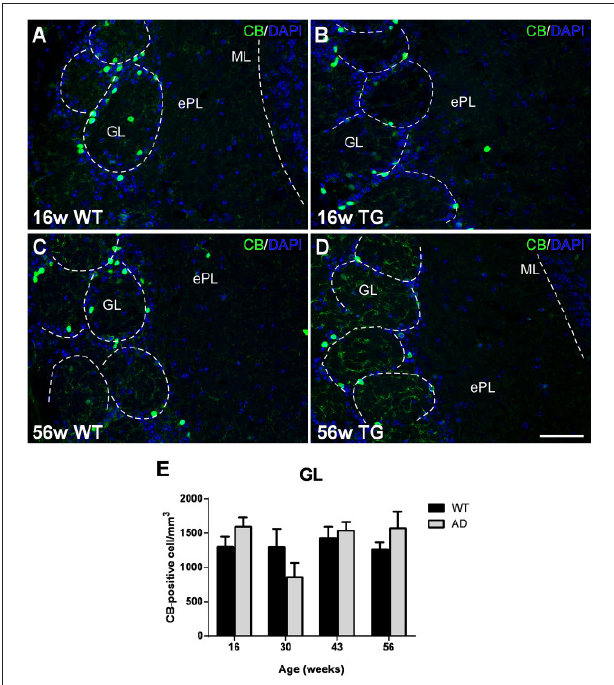
FIGURE 4 | Vulnerability analysis of parvalbumin-expressing cells in the olfactory bulb. (A–D), confocal images showing parvalbumin-positive cells in the mitral/external plexiform layer of control and transgenic animals at different ages. (E) , Graphics illustrating the estimation of parvalbumin-positive cells/mm 3 in control and transgenic animals in the mitral/external plexiform layer with aging. Calibration bar, 50 µ m. White arrows point to labeled cells. * P < 0.05